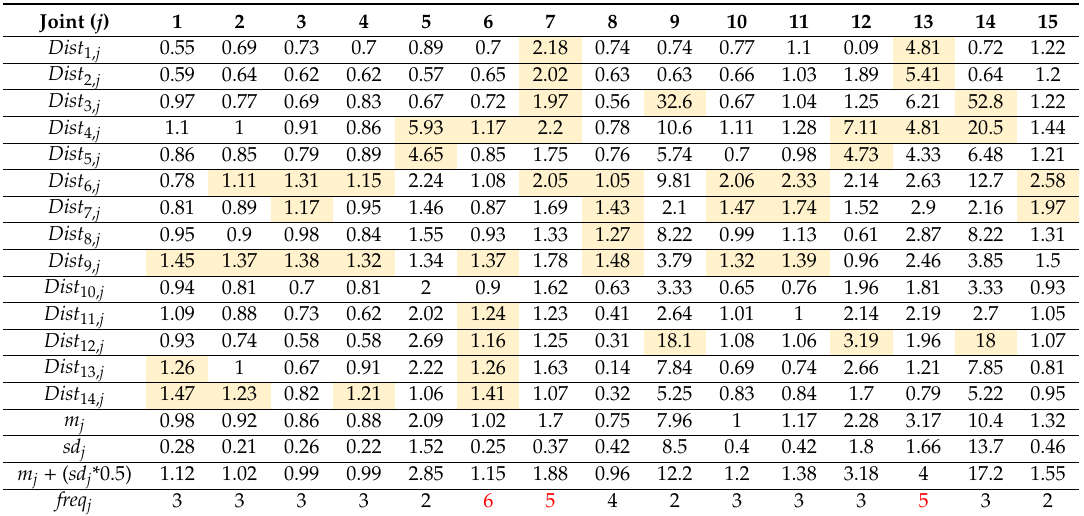
Table 2. Calculation of joint movement frequency from skeletal joint distance